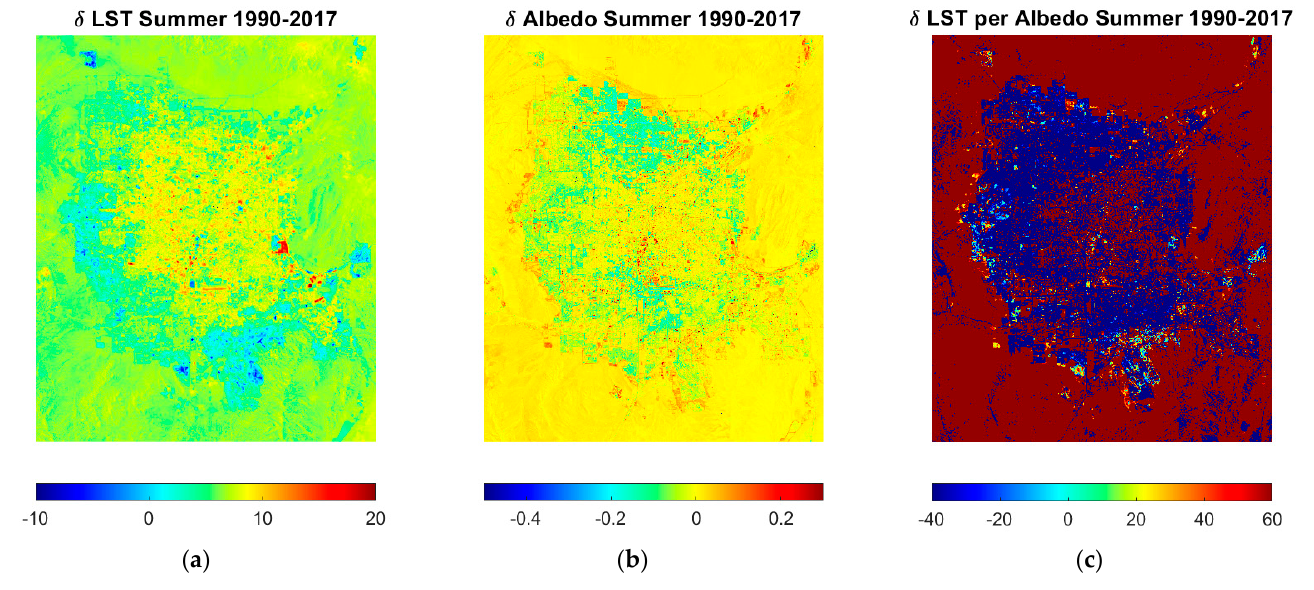
Figure 2. Spatial distribution of ( a ) LST and ( b ) albedo change acquired through OLI-derived dataset in Las Vegas Valley; the change was estimated by subtracting a 5-year underdeveloped (1990–1995) average summer image from a developed (2012–2017) summer image; ( c ) the changes in LST per unit albedo is acquired by dividing ( a ) by ( b ).